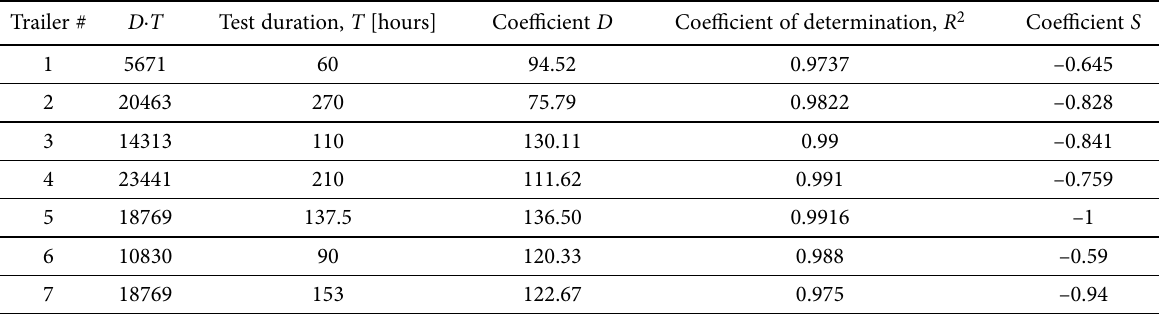
Table 3. Coefficients S and D for